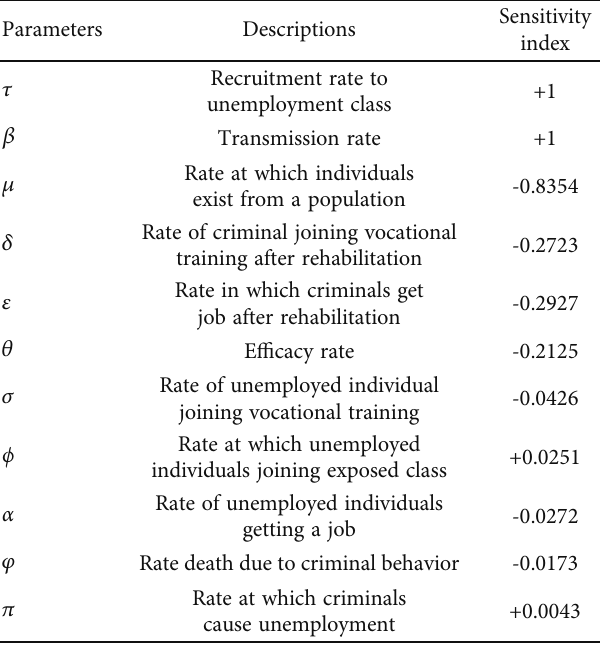
Figure 2: Backward bifurcation. Table 2: Description of state variables and parameters in the